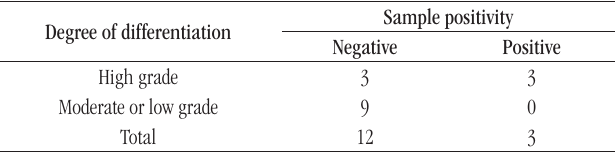
taBLE 2 − Association between result of peritoneal lavage and degree of tumor differentiation of ovarian carcinoma ( n = 15) Degree of differentiation